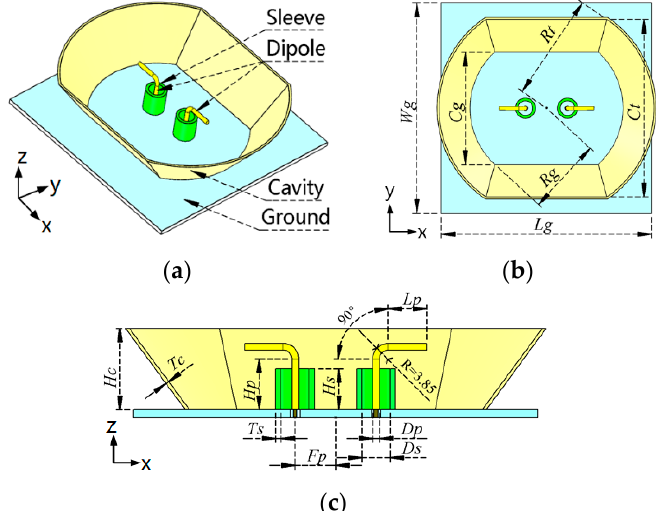
Figure 1. Configuration of the proposed antenna. ( a ) perspective view; ( b ) top view; ( c ) section-cut view.